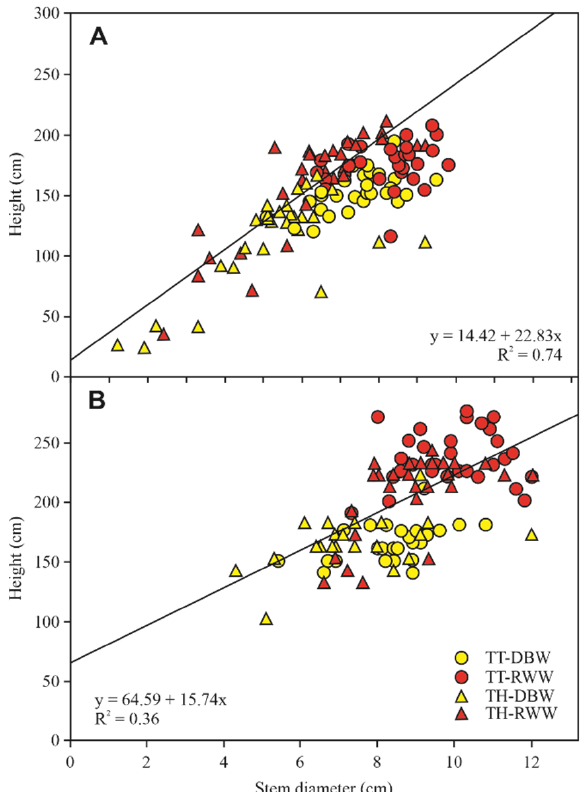
Figure 1. Stem diameter ( A ) and height ( B ) of Jatropha curcas at two different stages of cultivation and under different treatments. Figure adapted from [68].